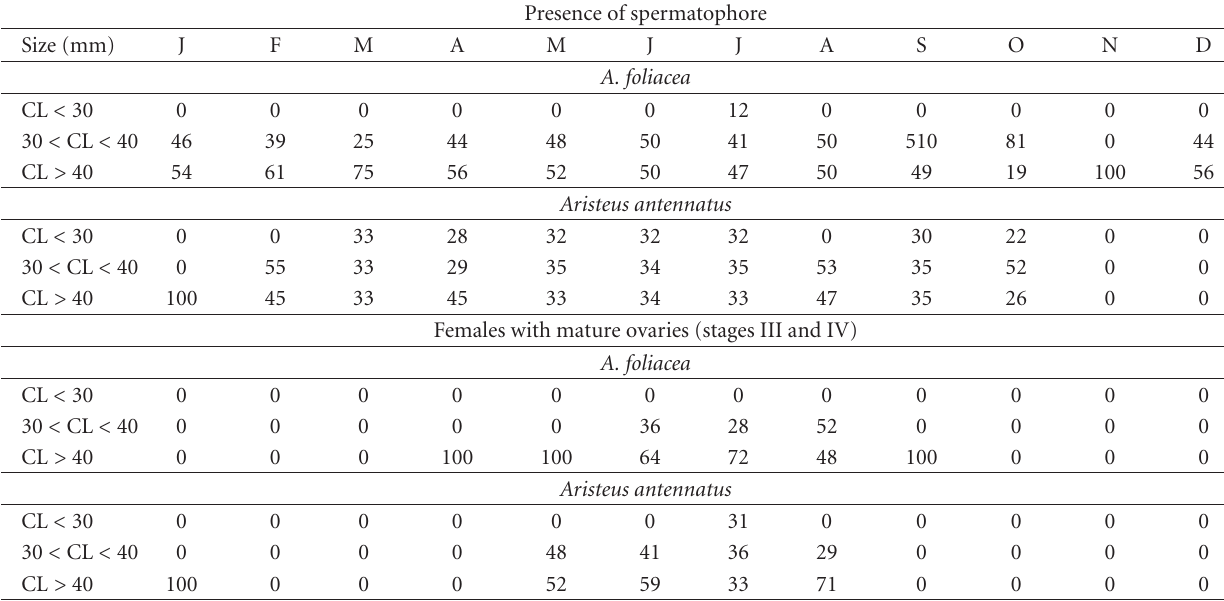
Table 1: Monthly spermatophore and mature ovaries occurrence (%) per size group for A. foliacea and Aristeus antennatus. Presence of